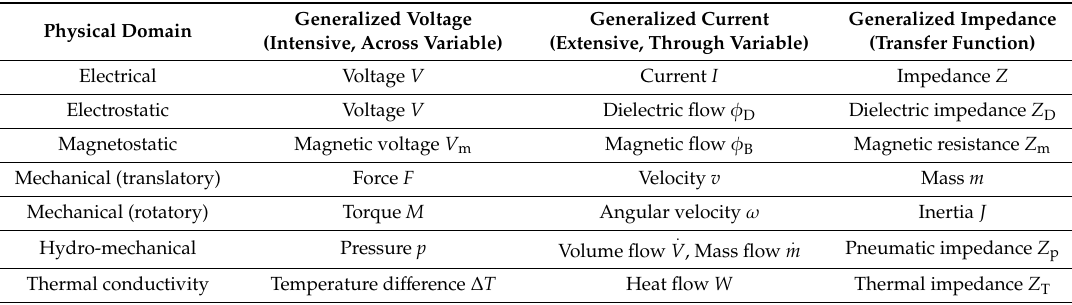
Table 1. Generalized impedances of different physical domains in analogy to the standard impedance definition of the electrical domain.